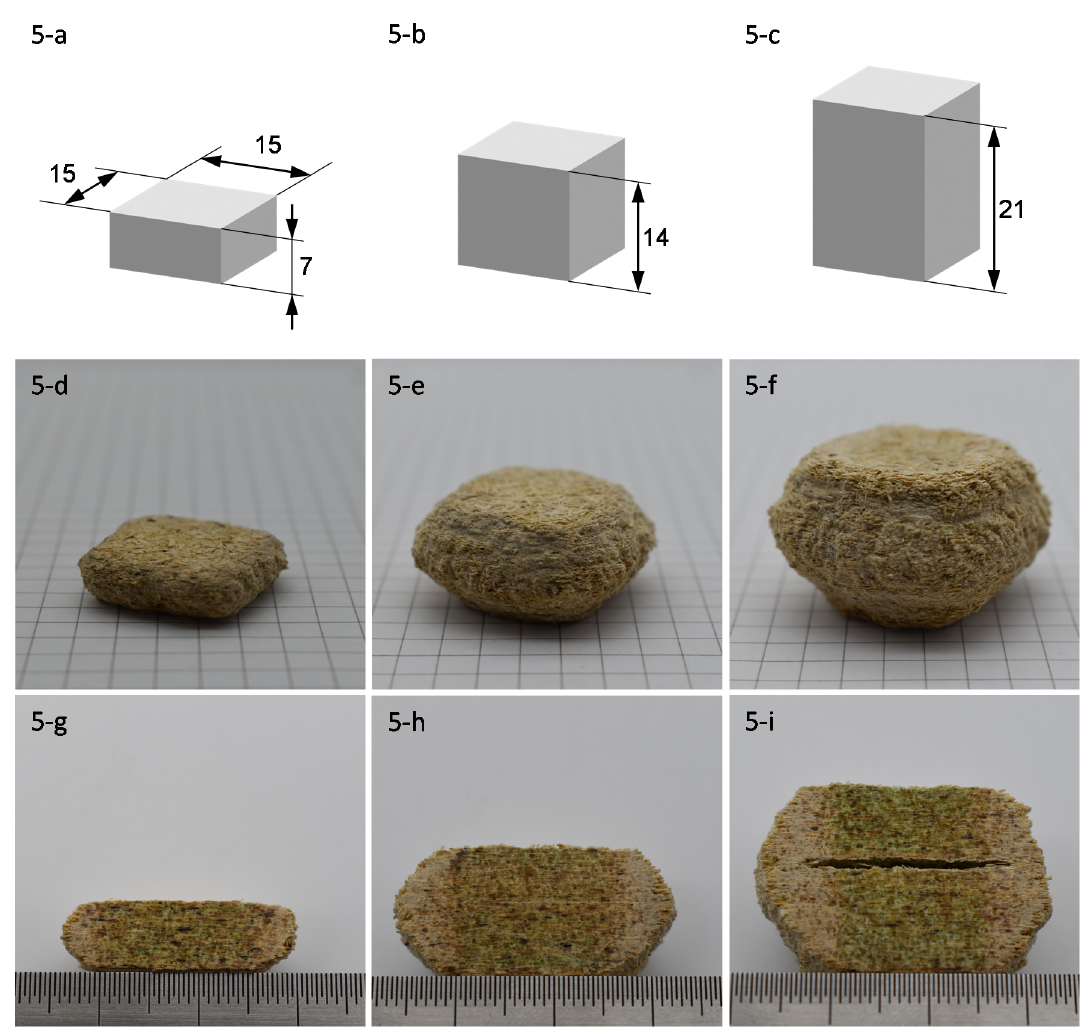
Figure 5. ( a – c ): Original CAD data of the planned rectangular cuboid specimens with a height of 7, 14, and 21 mm; ( d – f ) produced cuboids (background: standard 5 mm graph paper); ( g – i ) cross-sections of the specimens (distance between large ticks: 10